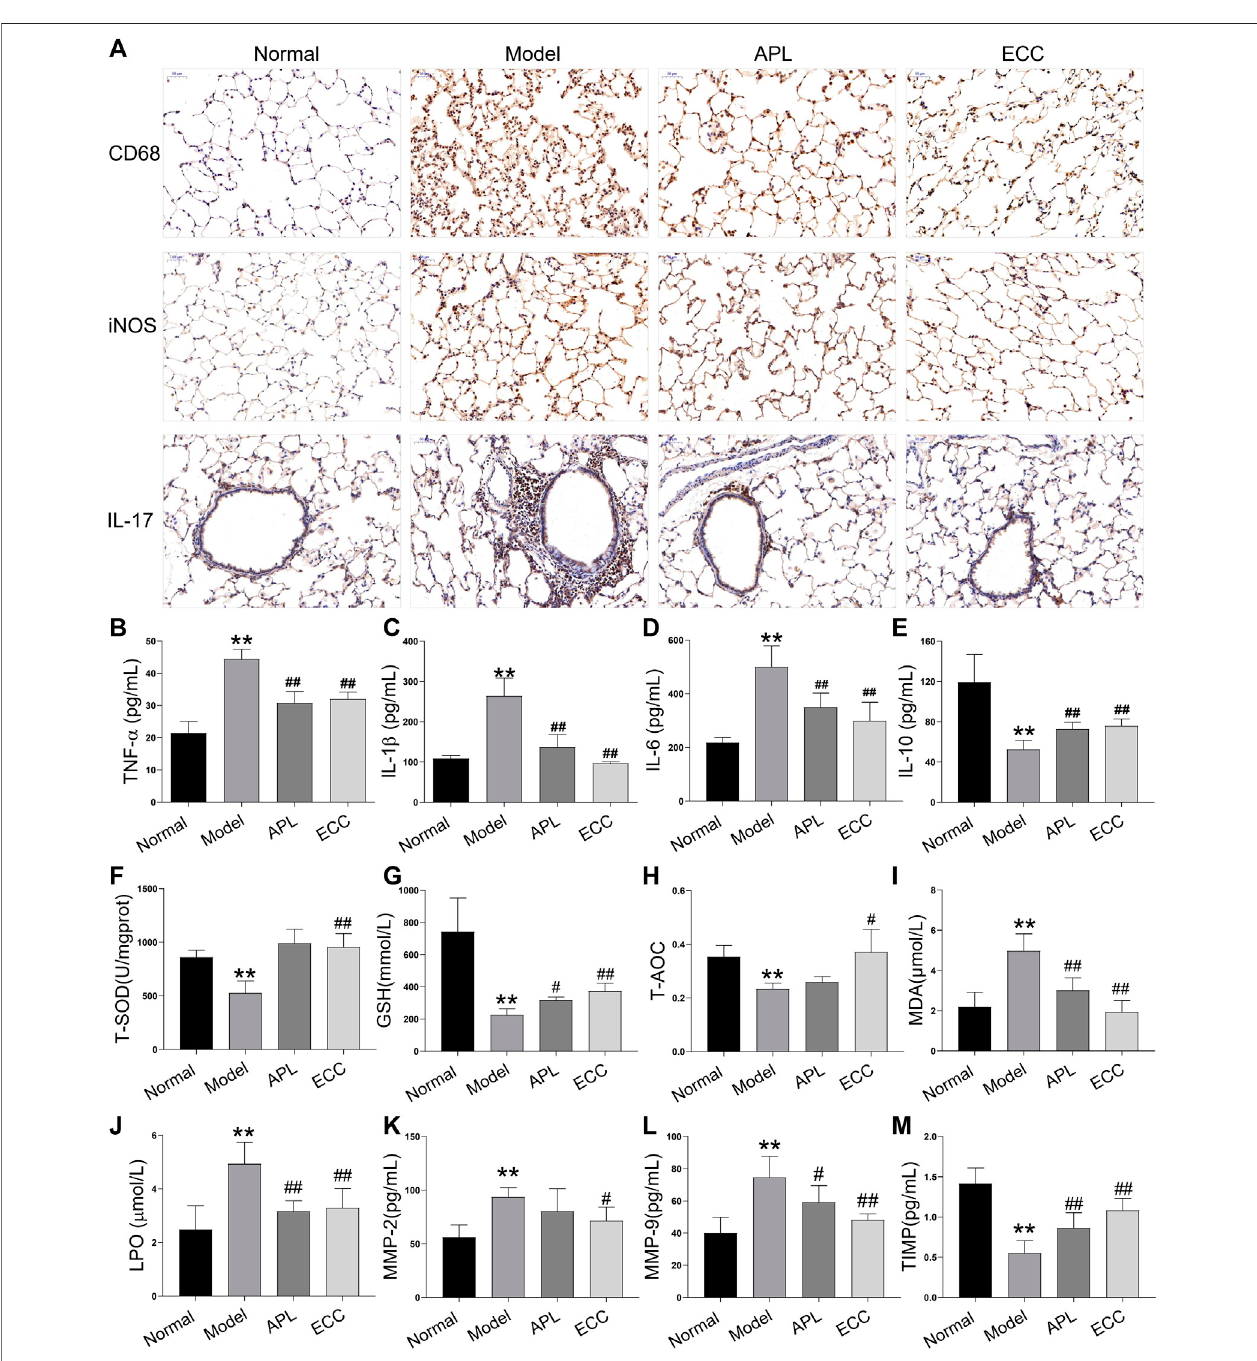
FIGURE7| EffectofECConin fl ammation,oxidativestress,andproteinase/anti-proteinaseinratswithCOPD.RatswithCOPDweretreatedwithECC(5.5 mg/ kg) and aminophylline (APL; 54 mg/ kg) for 8 weeks (weeks 12 – 20). (A) Macrophage marker, CD68, and iNOS were tested in lung tissue via immunohistochemistry. Levels of (B) TNF- α , (C) IL-1 β , (D) IL6,and (E) IL-10cytokinesweredetectedusingELISA.Serumlevelsof (F) T-SOD, (G) GSH, (H) T-AOC, (I) MDA,and (J) LPOweredetected using kits. In lung tissue, (K) MMP-2, (L) MMP-9, and (M) TIMP-1 were detected using ELISA. All data are presented as themean ± SEM ( n (cid:2) 6for each group) vs . normal, ** p < 0.01, vs . model, # p < 0.05, ## p < 0.01.